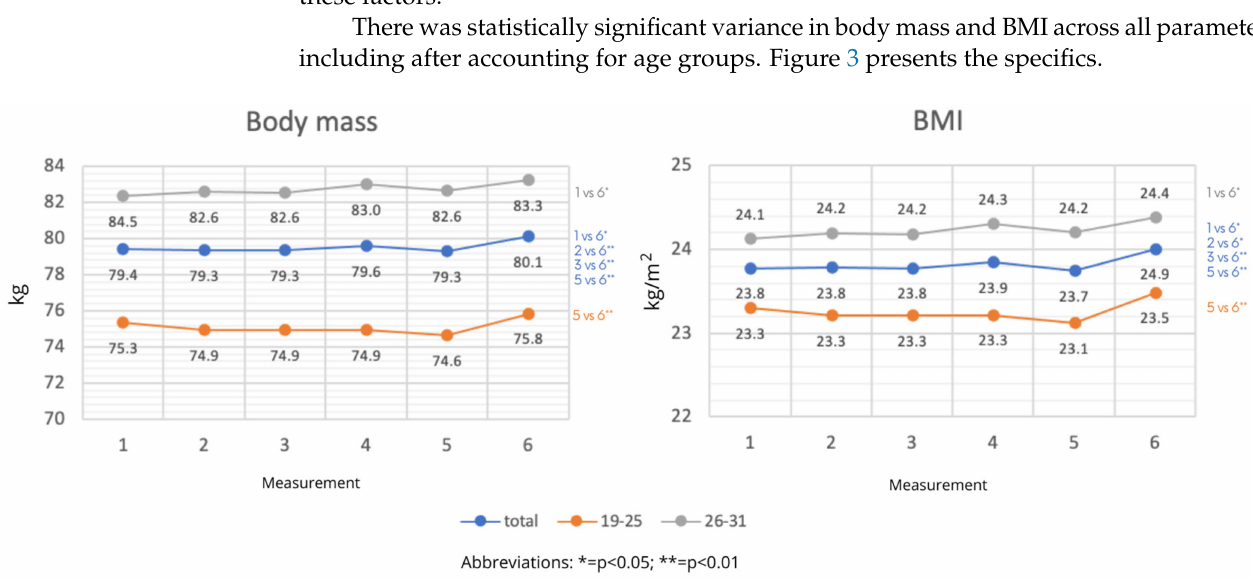
Figure 3. Changes in body weight, and BMI of participants during the training macrocycle by age category (average